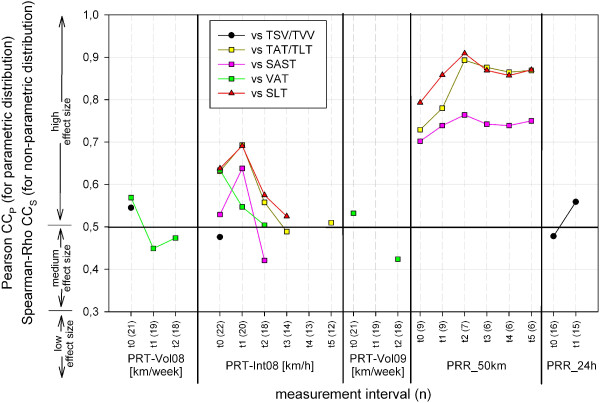
Correlation (one-tailed test) of percentage volumes and prerace performance.